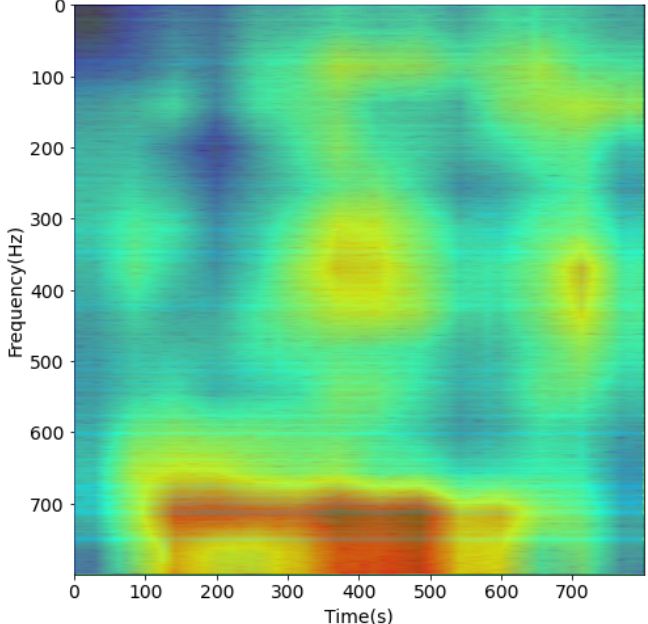
Figure 19. Proposed CNN Heatmap with spectrogram of Record